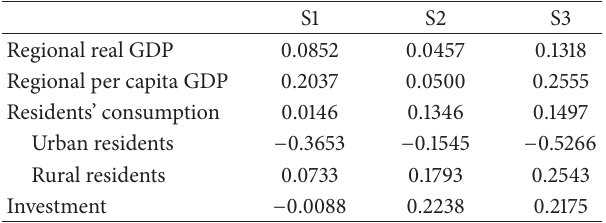
Table 2: Macroeconomic variables in 2015 (%